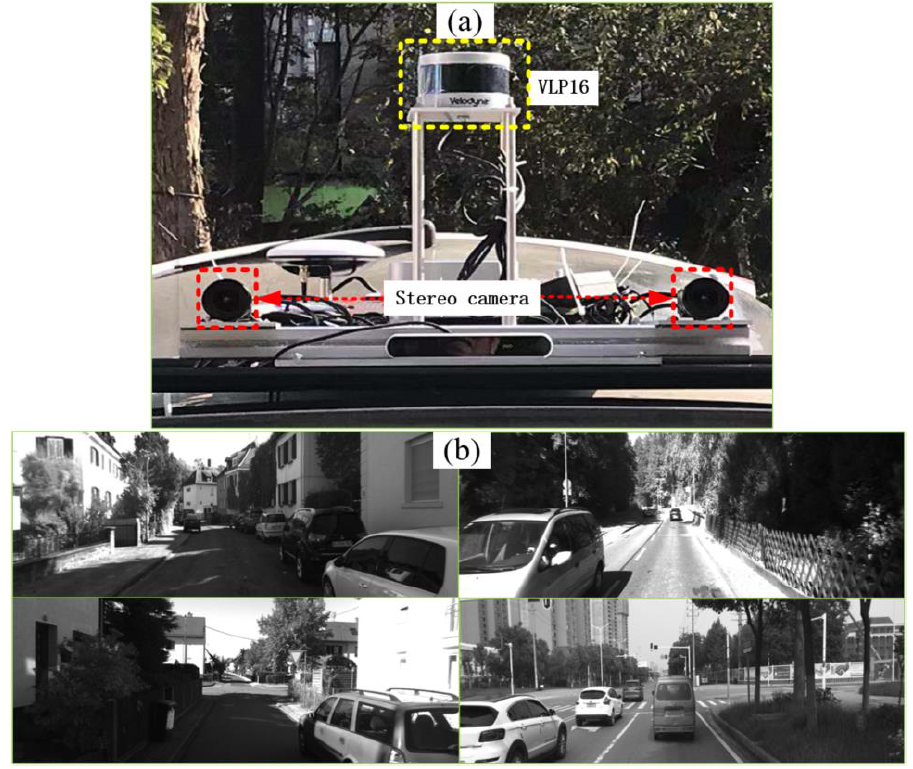
Figure 4. Data recording platform and corresponding collection environment. ( a ) Data recording platform; ( b ) data collection environment.